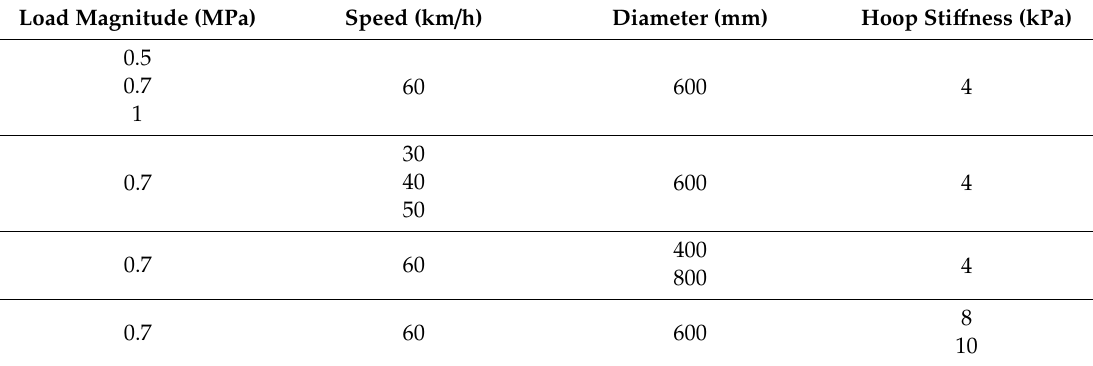
Table 7. Simulation tra ffi c load and pipe physical